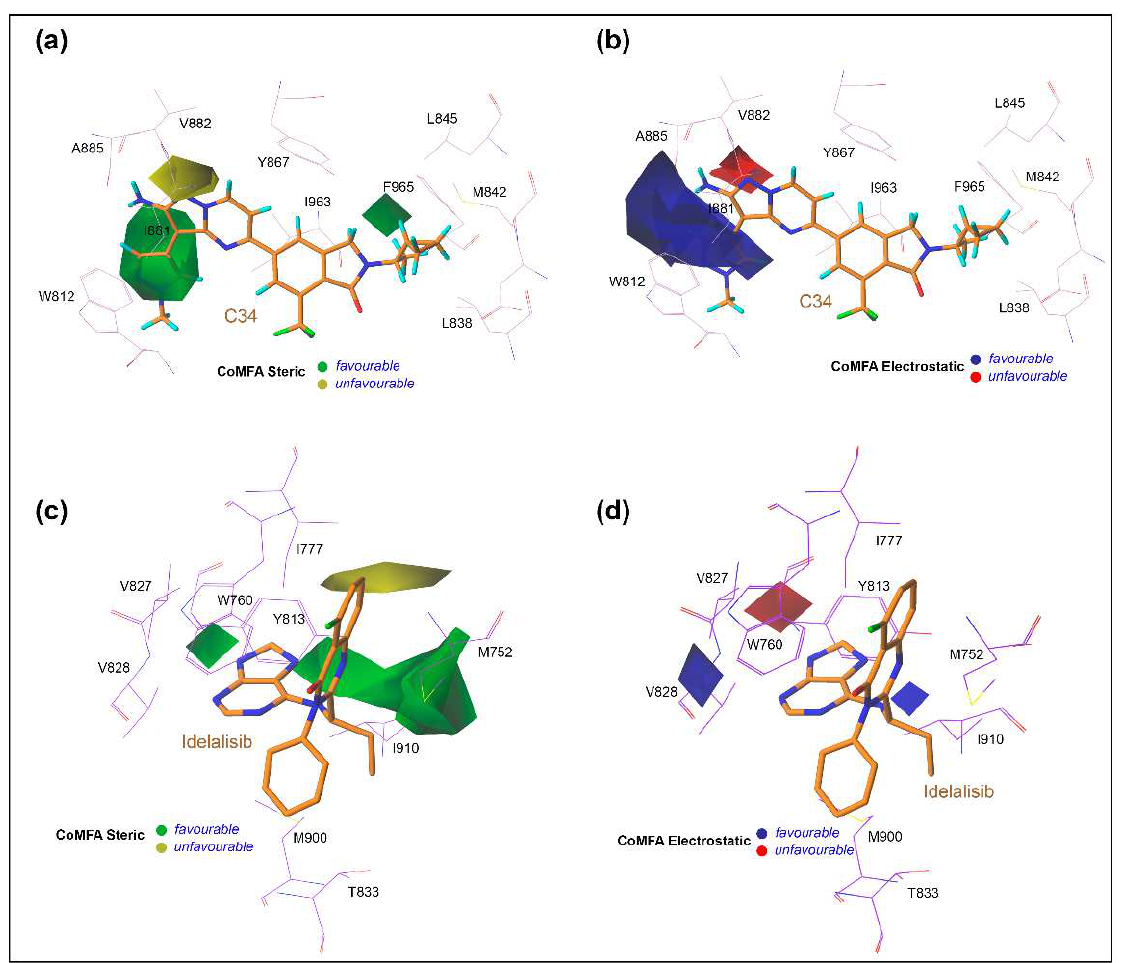
Figure 8. The standard deviation of coefficient contour maps of PI3K γ and PI3K δ CoMFA models. ( a , b ) contour maps depict the favorable and unfavorable substitutions for steric and electrostatic chemical groups over C34 in the PI3K γ CoMFA scheme. ( c , d ) signify the favorable and unfavorable substitution for steric and electrostatic chemical groups in the PI3K δ CoMFA scheme by taking the template molecule idelalisib as reference.